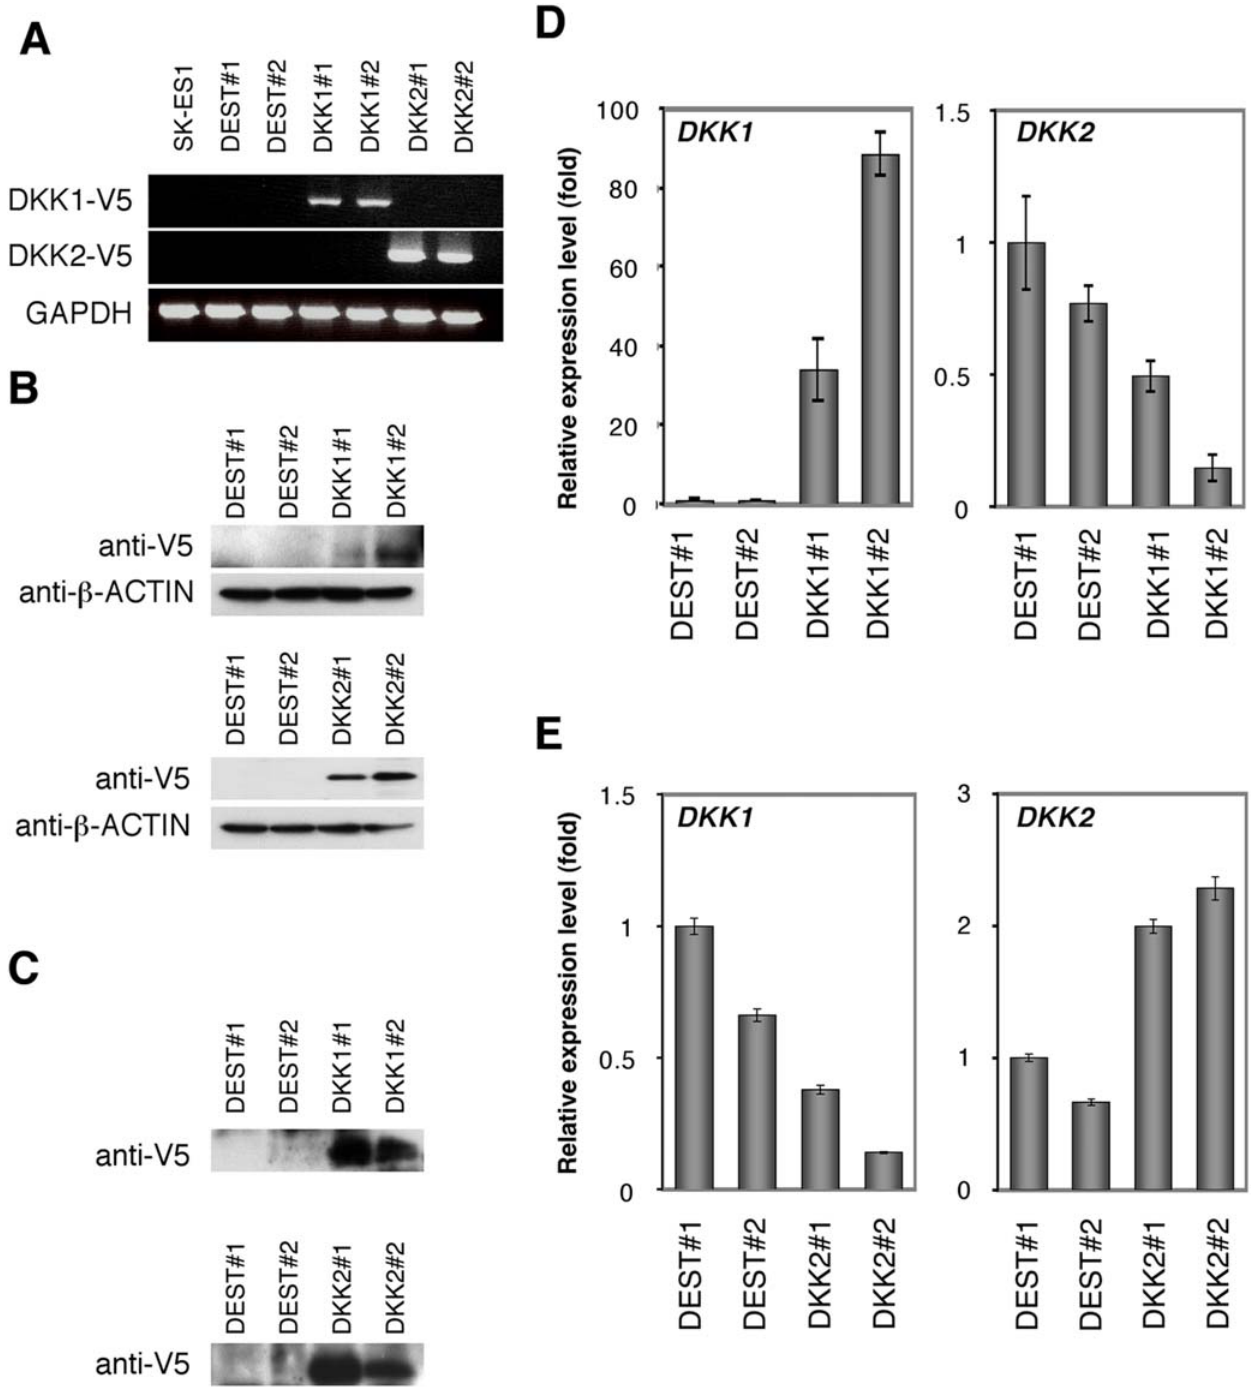
Figure 6. Mutually exclusive expression of DKK1 and DKK2 in SK-ES1 cells. A , B , Validation of DKK-V5 expression in SK-ES1 cells. The expression of DKK1-V5 and DKK2-V5 in SK-ES1 transfectants was observed by RT-PCR ( A ) and Western blot analysis ( B ). DEST # 1, # 2: SK-ES1-DEST # 1, # 2, DKK1 # 1, # 2: SK-ES1-DKK1 # 1, # 2, DKK2 # 1, # 2: SK-ES1-DKK2 # 1, # 2. As an internal control, human GAPDH (for RT-PCR) and b –Actin (for Western blot) were used, respectively. C , Secretion of DKKs-V5 into cell culture supernatants. Secreted DKKs-V5 proteins were absorbed by TALON Metal Affinity Resin (Clontech) and analyzed by Western blotting, D , E , Relative level of DKK1 and DKK2 in SK-ES1 transfectants in SK-ES1-DKK1 ( D ) and SK-ES1-DKK2 ( E ). Signal intensity was normalized using that of a control housekeeping gene (human GAPDH gene). Data are relative values with the SD for triplicate wells and normalized to the mRNA level at DEST # 1 which is arbitrarily set to 1.